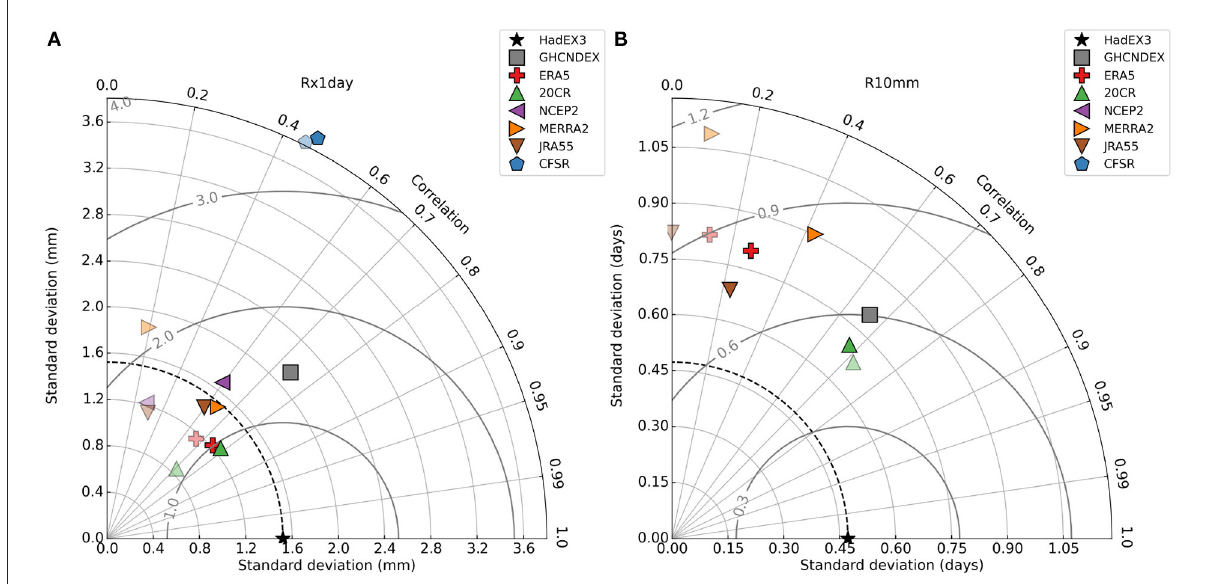
FIGURE8 Taylor diagram for (A) Rx1day and (B) R10mm. The fainter symbols are for reanalyses using complete global land coverage, the darker ones are matched to the spatio-temporal coverage of HadEX3.